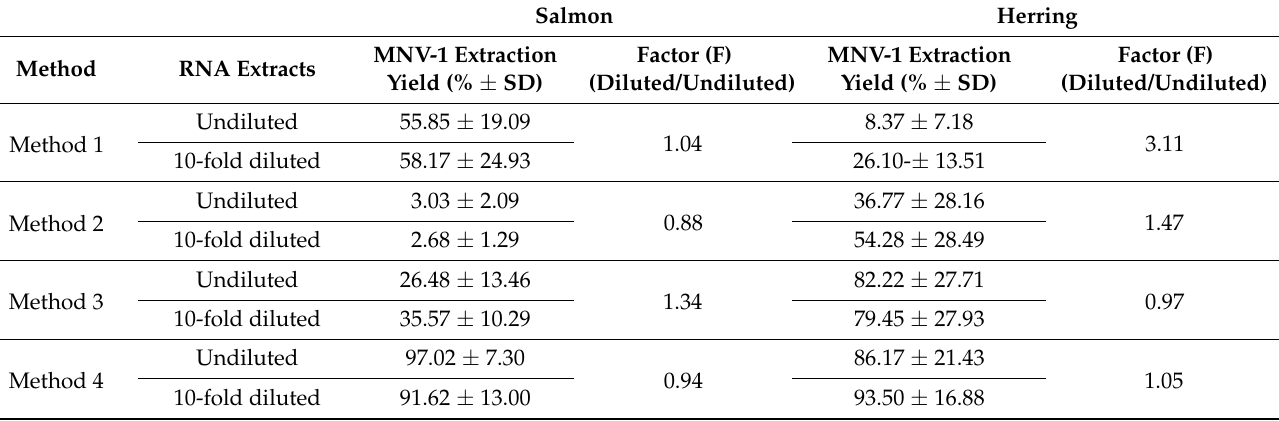
Table 3. Comparison of mean recovery rates of MNV-1 from artificially contaminated salmon and herring samples processed using four study